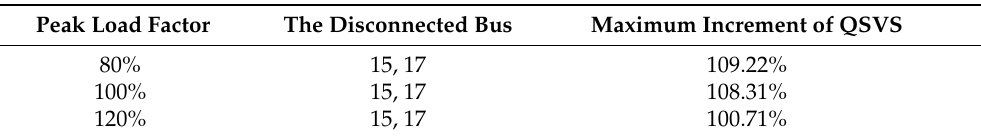
Figure 8. Variation of QSVS at each removal loads and for each peak load factors on IEEE 33-bus test distribution system. Table 7. The candidate locations of two RDGs installation for each peak load factor of IEEE33-bus test distribution system using Algorithm 1.